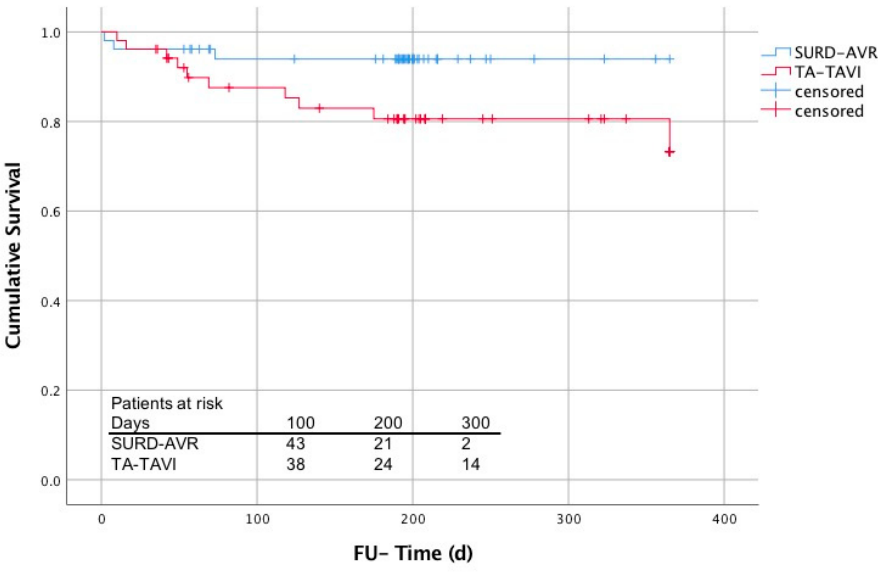
Figure 1. Estimated survival (Kaplan–Meier) comparing SURD-TAVI and